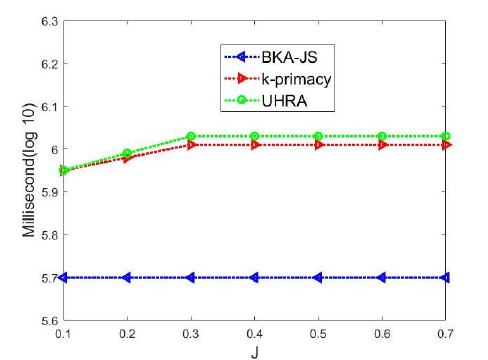
Figure 4. Execution time (in milliseconds with log 10 scale) of our algorithm with t = 0.5 and k = 5 regarding various J values on the BKseq dataset.